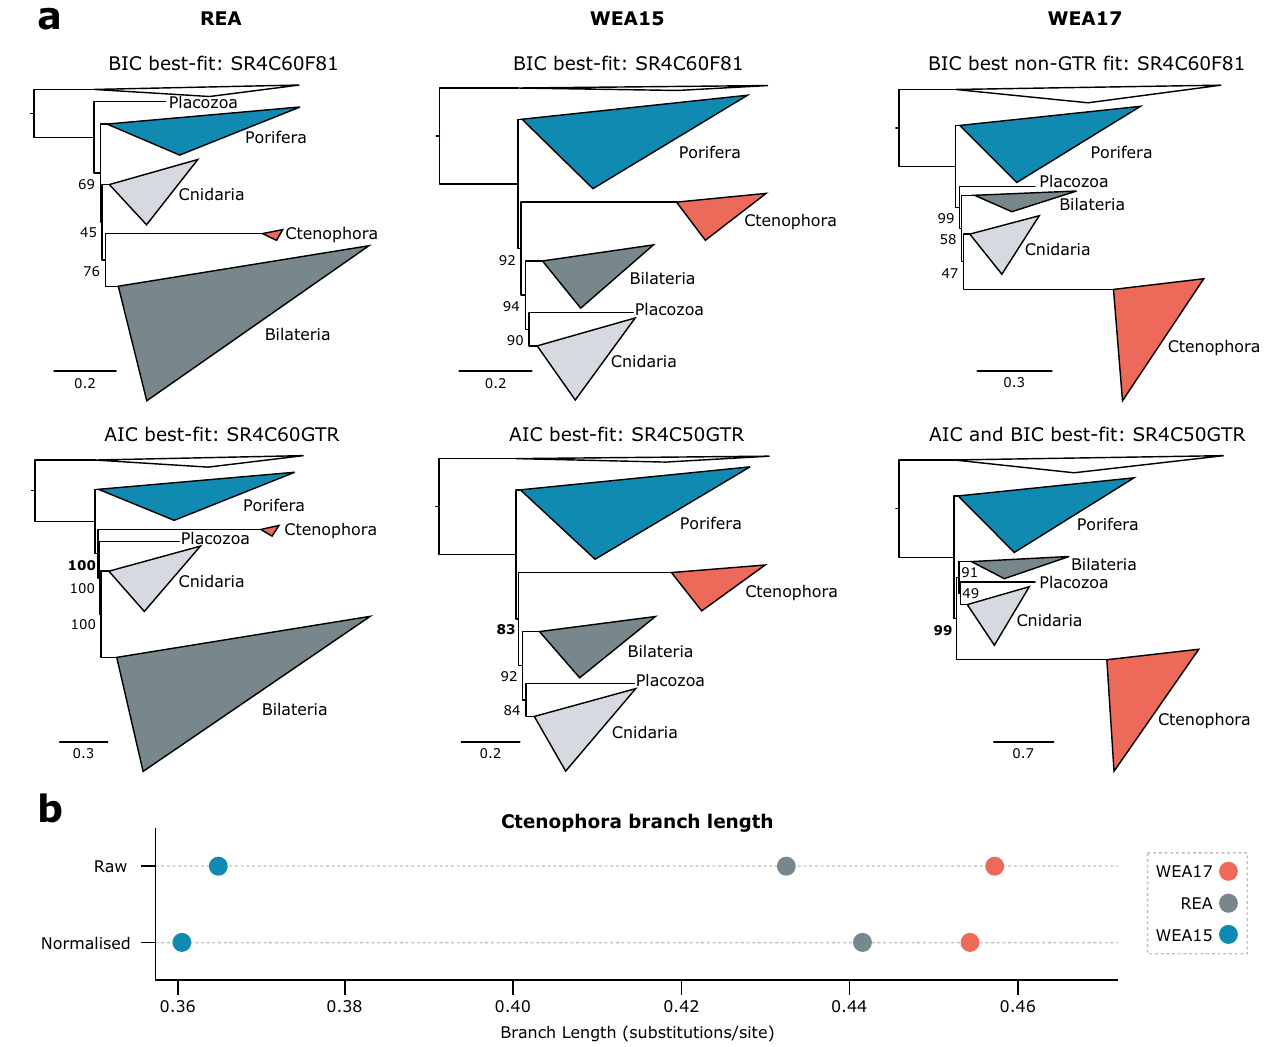
Fig. 1 | Unpartitioned recoding reanalyses and ancestral ctenophore branch lengths. a Reanalyses of SR4 recoded animal phylogeny datasets REA, WEA15,and WEA17 without using partitioning. Consensus trees from reanalyses with best- fi tting F81-based models are shown in the top row and those from reanalyses with best- fi tting GTR-based models are shown in the second row. Model- fi tting results reported above each tree compared both F81 and GTR-based models (including site-homogeneous F81 and GTR). Ultrafast bootstrap support for Porifera-sister is